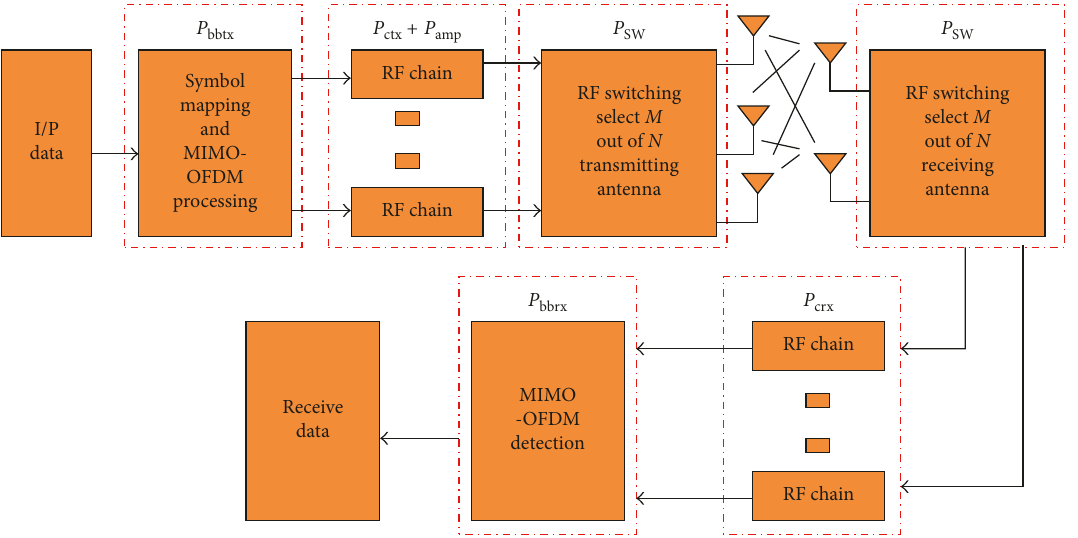
Figure 1: Block diagram of the M-MIMO-OFDM transmitter and receiver with antenna